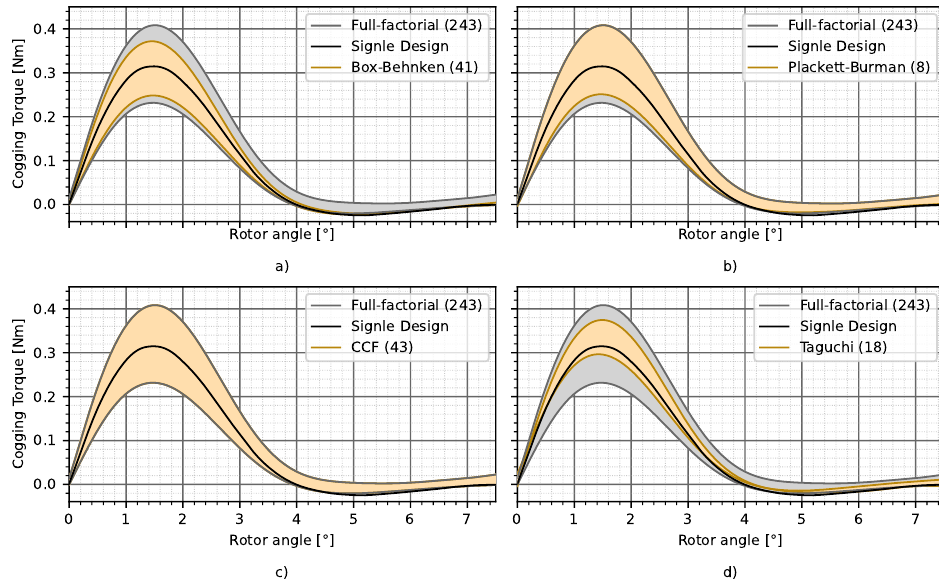
Figure 13. The mean value of the calculated cogging torque and its tolerances with different DoE strategies: Full-facorial designs represented by the gray zone and its results compared by Box- Behnken design ( a ), Plackett-Burman ( b ), CCF ( c ) and Taguchi design ( d